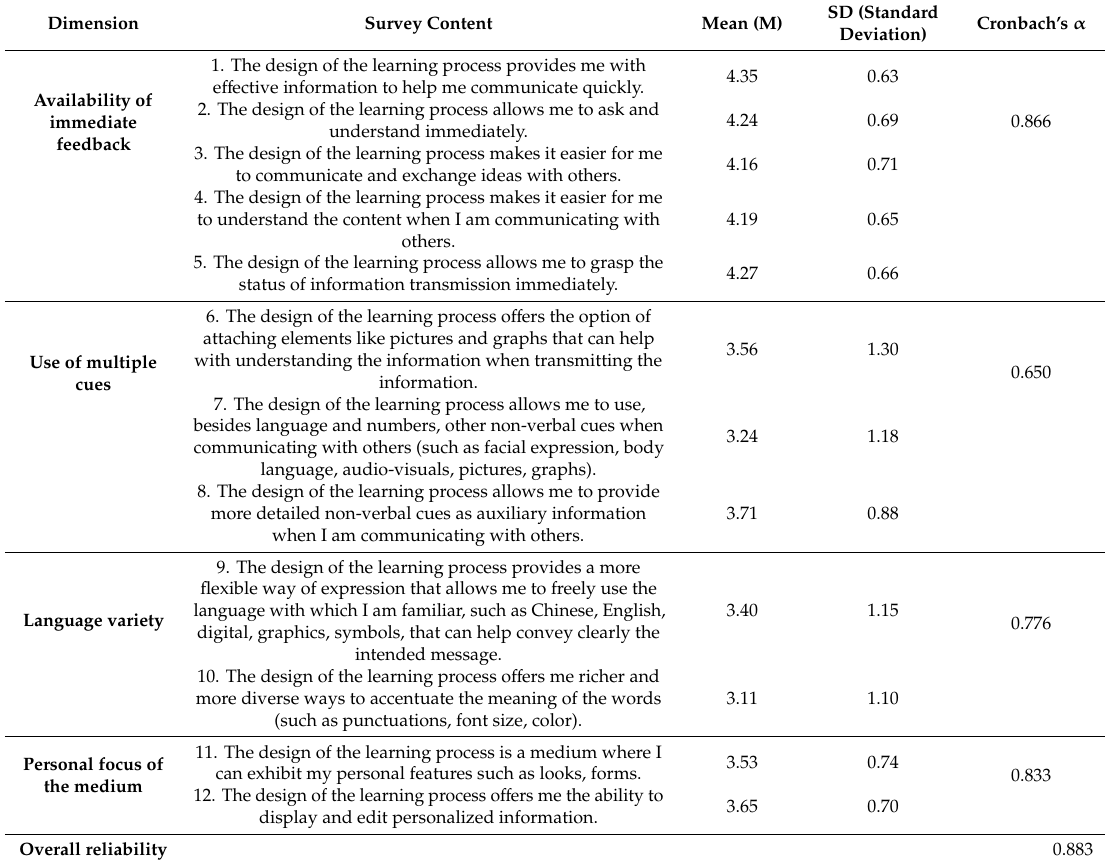
Table 4. The questionnaire reliability of media